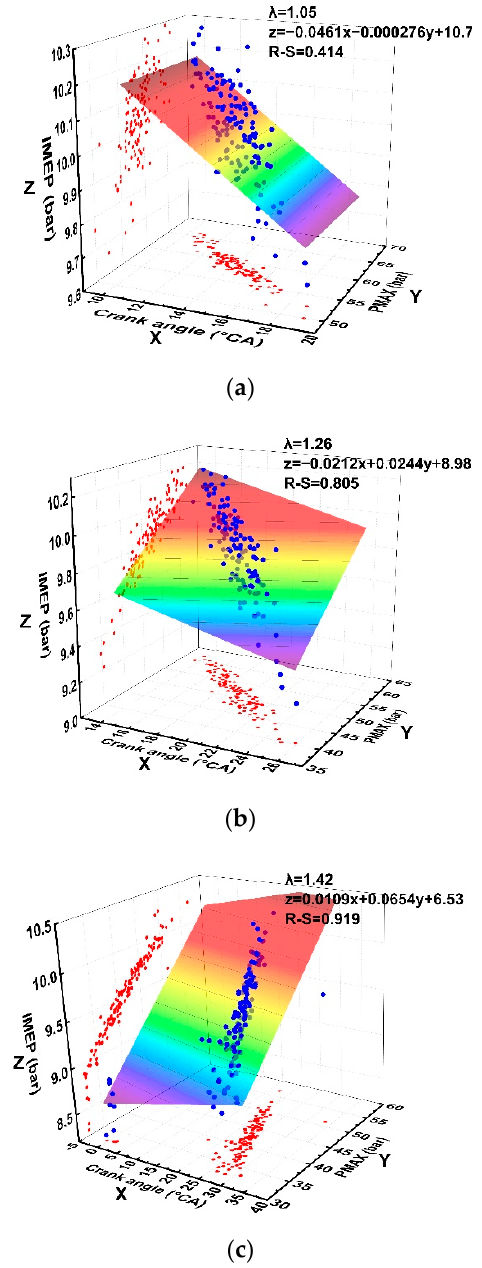
Figure 6. Fitting of IMEP and PMAX distribution under different λ : ( a ) The fitting of IMEP and PMAX at λ = 1.05; ( b ) The fitting of IMEP and PMAX at λ = 1.26; ( c ) The fitting of IMEP and PMAX at λ = 1.42.